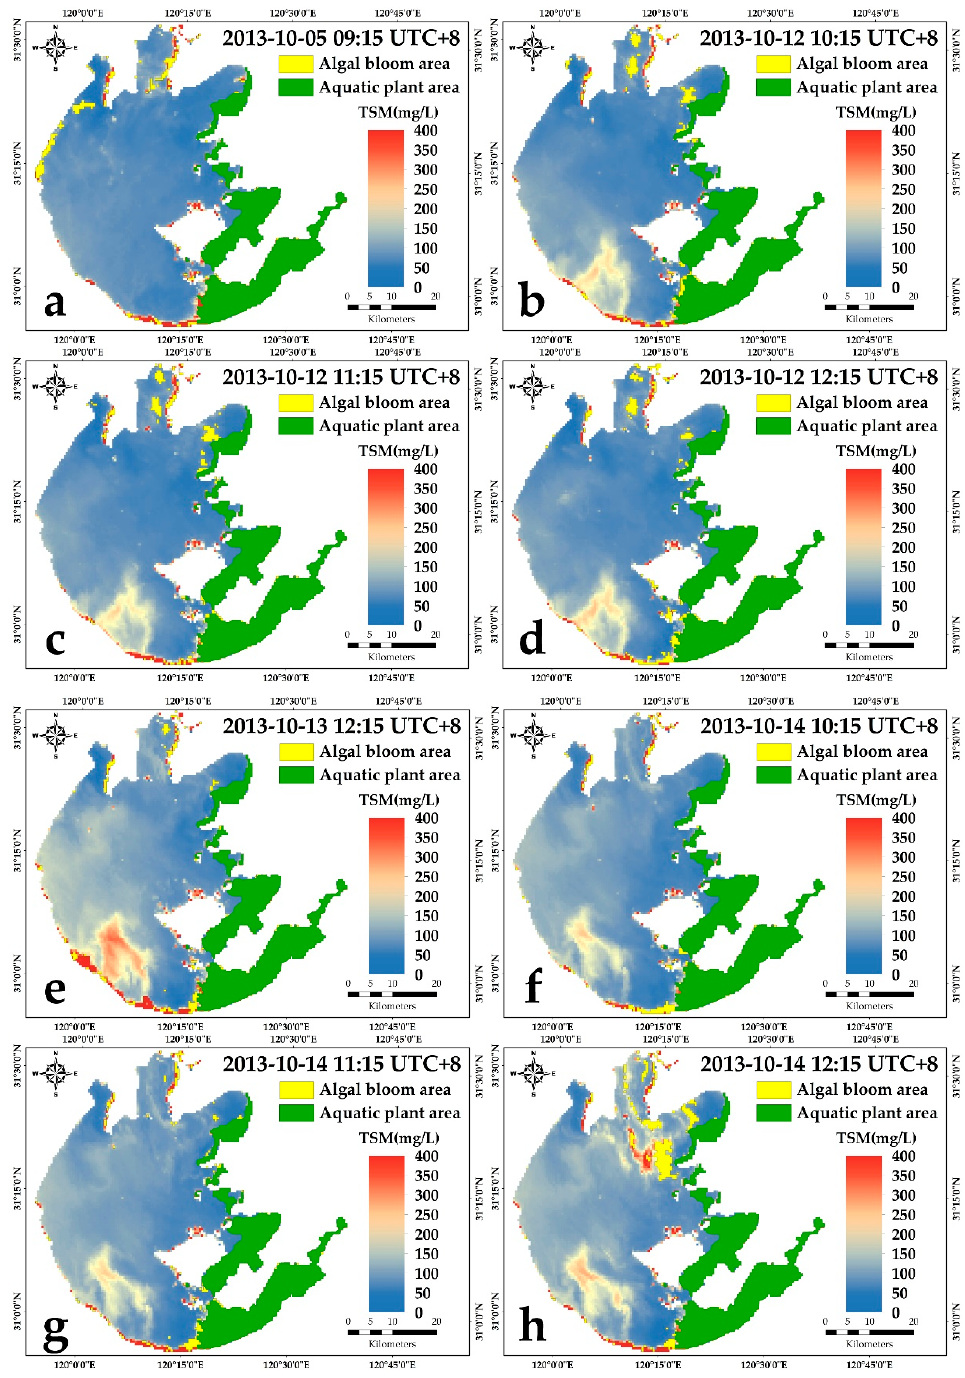
Figure 6. Distribution of TSM in Lake Taihu in mid-October 2013 ( a–h ).